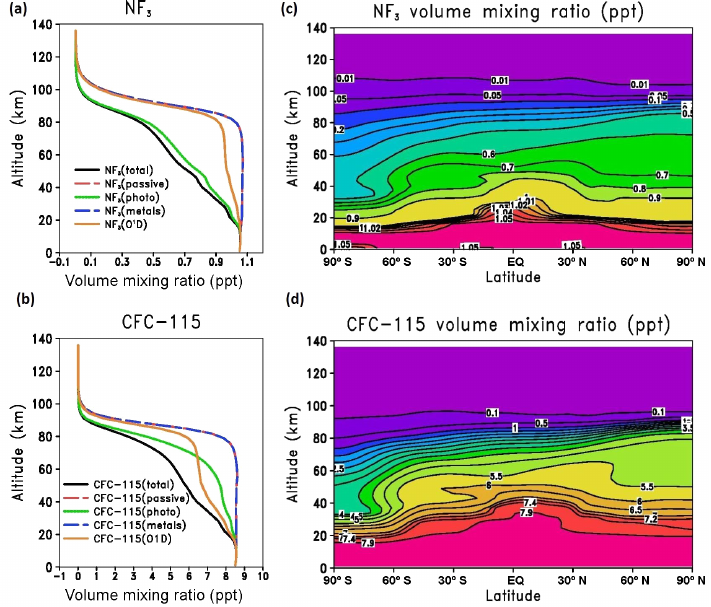
Figure 3. (a) Globally averaged NF 3 mixing ratio in January of the thirteenth year of the WACCM simulation, illustrating the profiles of the four individual tracers (passive, photolysis, metal reaction and reaction with O( 1 D)). (c) The corresponding zonal mean NF 3 mixing ratio (ppt) as a function of altitude. (b) As (a) but for CFC-115. (d) As (c) but for